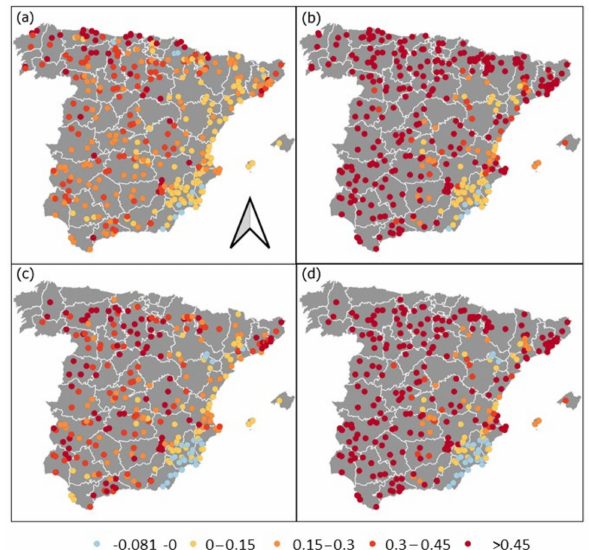
Figure 5. Increase of the static drought stress in Spain over the periods: ( a ) 2006–2040 vs. 2041–2070 and ( b ) 2006–2040 vs. and 2071–2100; and increase of the dynamic drought stress over the periods ( c ) 2006–2040 vs. 2041–2070 and ( d ) 2006–2040 vs. 2071–2100. Change is indicated as fractional and negative values indicate a drought stress